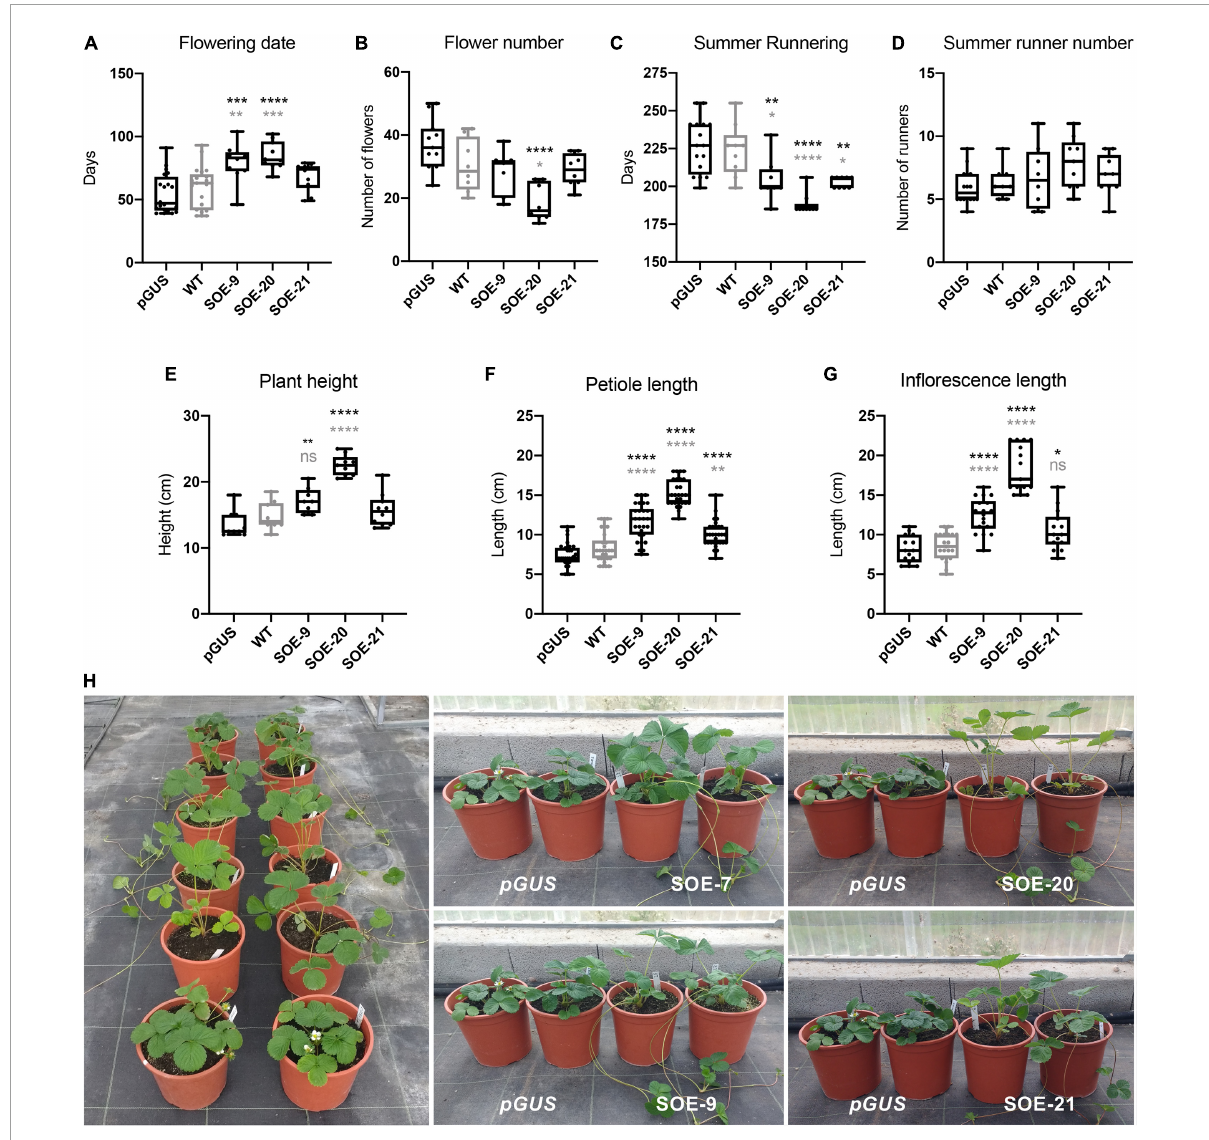
FIGURE4 Phenotype of 35S: FaSOC1 lines (SOE) in comparison to control plants. (A) Number of days to flowering from November 20th. (B) Total flower number (from November 20th until September 1st). (C) Number of days until the first summer stolon. (D) Number of stolons until September 20th. (E) Plant height. (F) Length of leaf petioles. (G) Length of inflorescence peduncle. Boxes span the 25th and 75th percentiles and the middle line represents the median. Whiskers (T-bars) are the minimum and maximum values. Asterisks represent significant differences between pGUS (in black) or ‘Camarosa’ wild type (WT; in gray) and 35S: FaSOC1 over-expresser plants; Statistical significance was determined by ANOVA and Tukey’s test (* P < 0.05, ** P < 0.01, *** P < 0.001, **** P < 0.0001). (H) Phenotype of 35S: FaSOC1 lines in comparison to control GUS plants. Two representative replicates are shown. Pictures were taken in